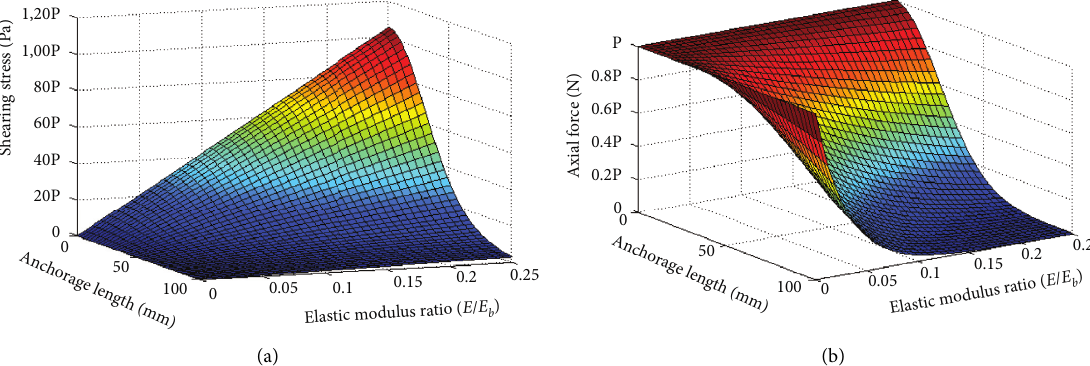
Figure 4: Distribution law of bolt-resin interface shear stress and bolt axial force. (a) Curved surface of bolt-resin interface shear stress; (b) curved surface of bolt axial